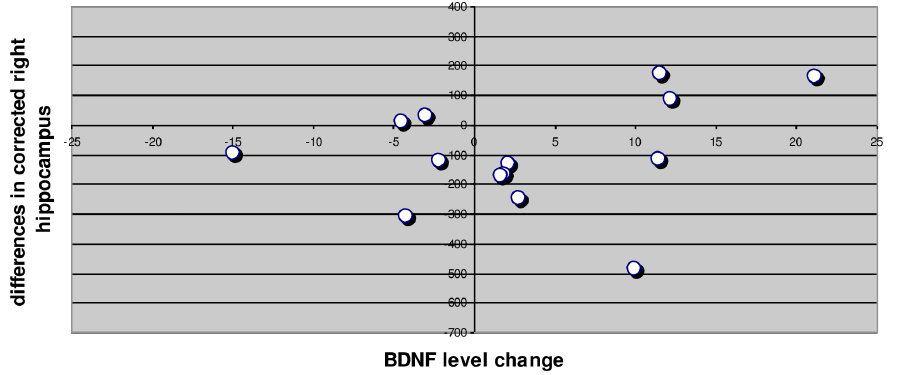
Figure 4. Differences in corrected right hippocampus and BDNF level change. Pearson r=0.281, p=0.330 (NS). Bootstrap Sampling method single. Bias=0.010, Std. Error=0.293, 95% Confidence interval 2 0.409 to